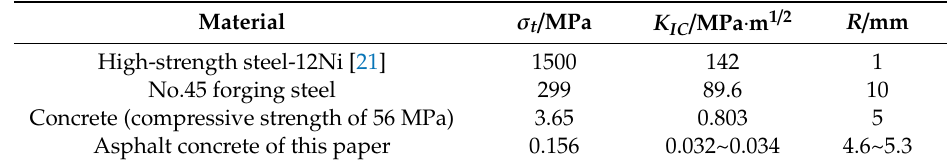
Table 6. Plastic zone radius R of di ff erent materials.